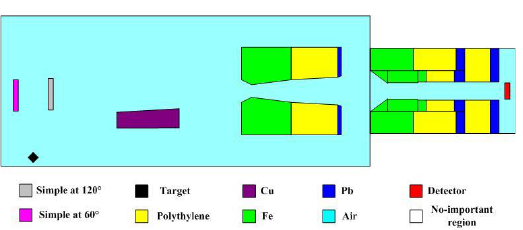
Fig.6 Model for the MCNP calculations with sample surface area of 30 cm×30 cm.